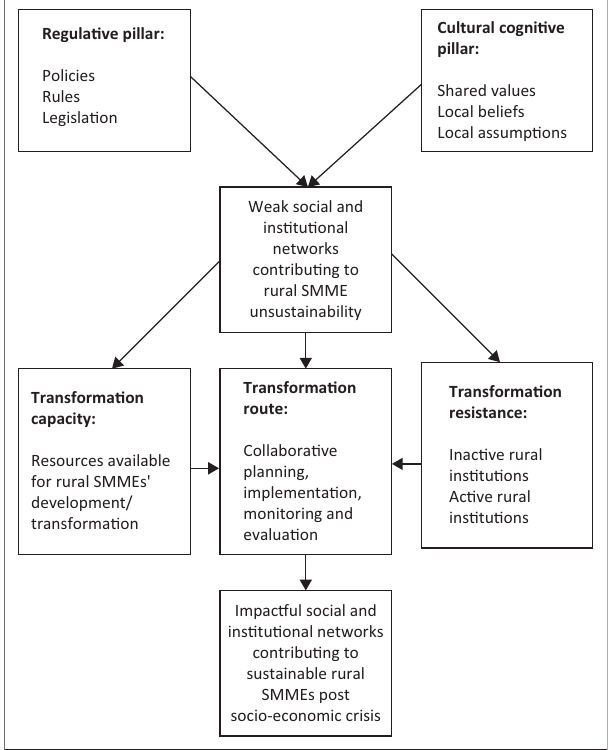
SMME, small, medium and micro enterprise. FIGURE 4: Conceptual model of the influence of regulative and cognitive elements in transforming unsustainable rural small, medium and micro enterprises into sustainable ones through impactful social and institutional